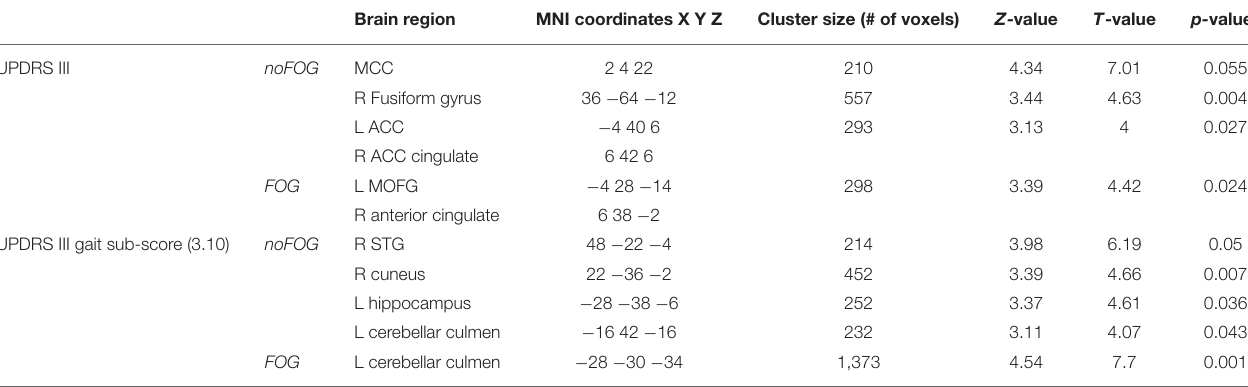
TABLE 3 | Brain regions within the brainstem network showing significant correlations between UPDRS III total score and UPDRS III gait sub-score (item 3.10) and RS-FC levels based on voxel-wise multiple regression. Brain region